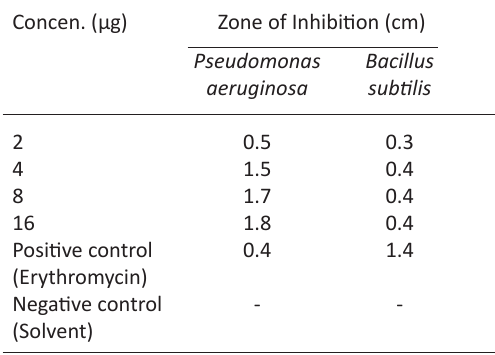
Table 1. Antibacterial activity of crude silver